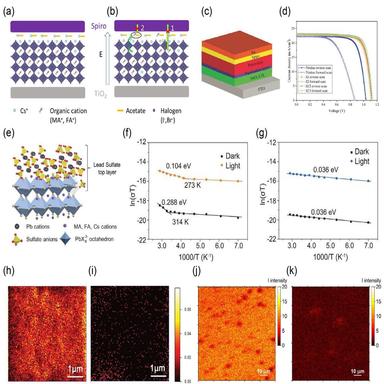
Schematic diagram of cesium acetate modified PSC before (a) and after (b) stability test. Copyright 2018, American Chemical Society. Device structure of PSCs with underlying passivation layers (c) and corresponding J-V curves (d). Copyright 2018, Wiley-VCH GmbH. (e) Illustration of in situ formation of a lead sulfate layer on the perovskite surface. Temperature-dependent conductivity of PTAA/CsFAMA perovskite/PCBM films without (f) and with (g) methylammonium sulfate treatment ]